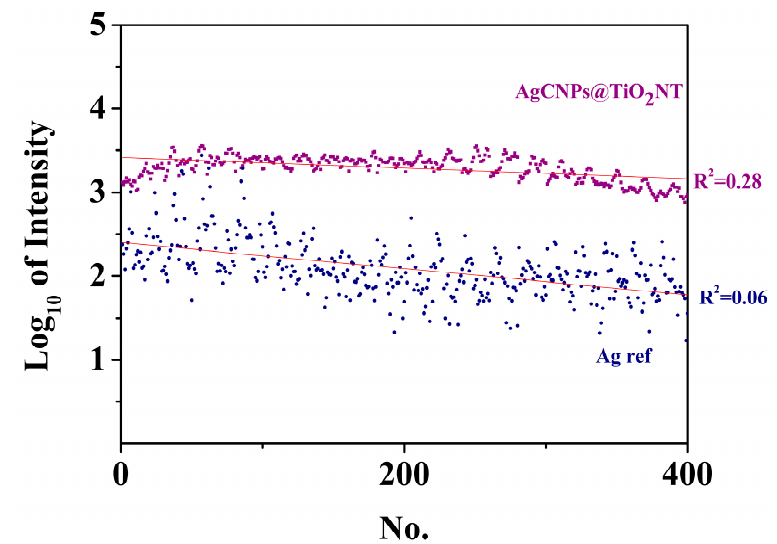
Figure 14. Logarithmic plot of the intensity of the pyridine band at 1004 cm − 1 recorded in each of the series of 400 measurements for pyridine adsorbed at AgCNPs@TiO 2 NT (violet) and silver electrode